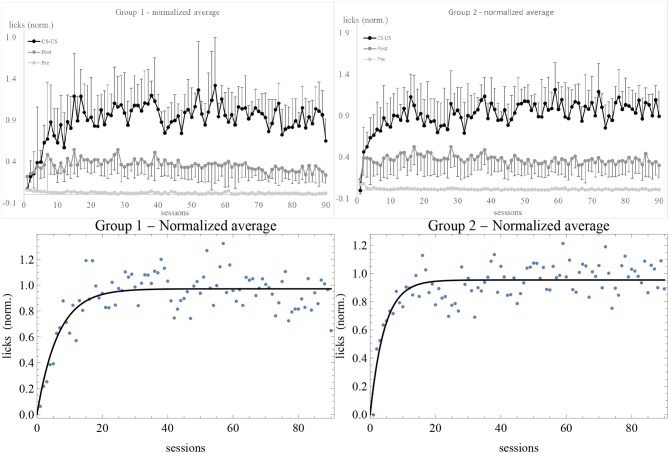
Average of normalized data for Group 1 (top left) and 2 (top right), together with the best fit with the RW model (bottom). Sessions are on the horizontal axis, number of licks on the vertical axis. Light gray, dark gray, and black data points (connected by lines of the same colors) are the licks in the 10 s, respectively before, during, and after the CS. The number of US has been subtracted from the during-CS licks of each individual before taking the average, and the upper and lower error bars at the 68% confidence level of CS and post-CS data are shown.